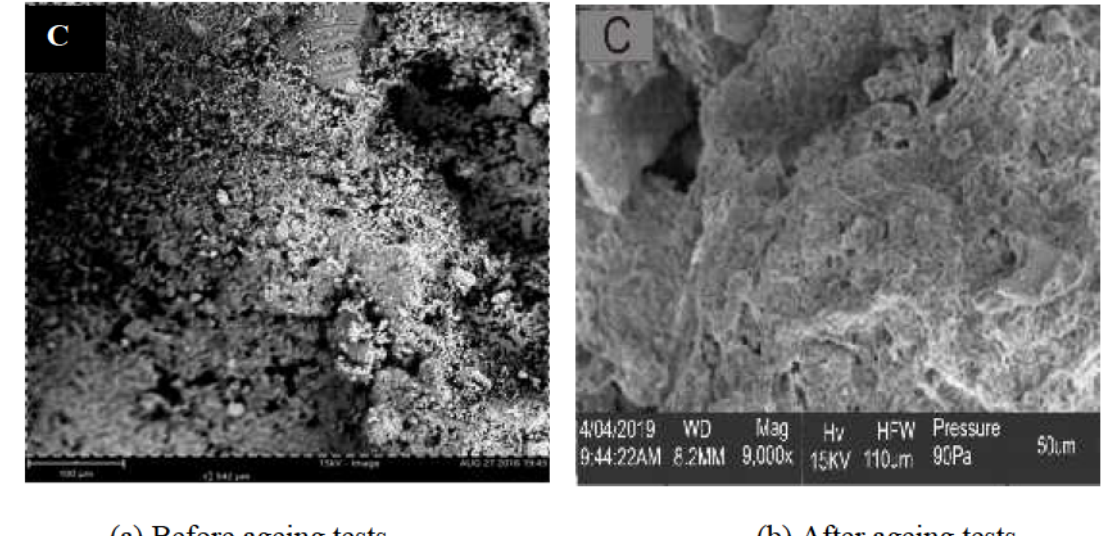
Figure 6: Sample C